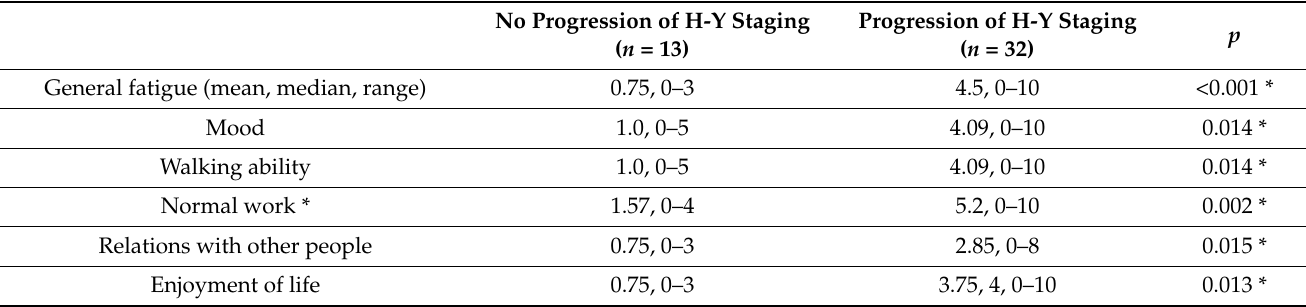
Table 4. Comparative subscores of Brief Fatigue Inventory of patients with PD with and without disease progression defined by an upgrade of Hoehn-Yahr stage.